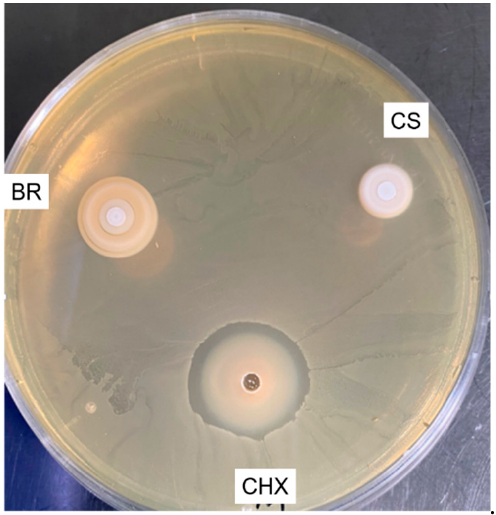
Figure 7. The inhibition zones around the di ff erent sealers and chlorhexidine (CHX) using agar di ff usion test. BioRoot (BR) and Ceraseal (CS) materials infiltrated into agar materials.